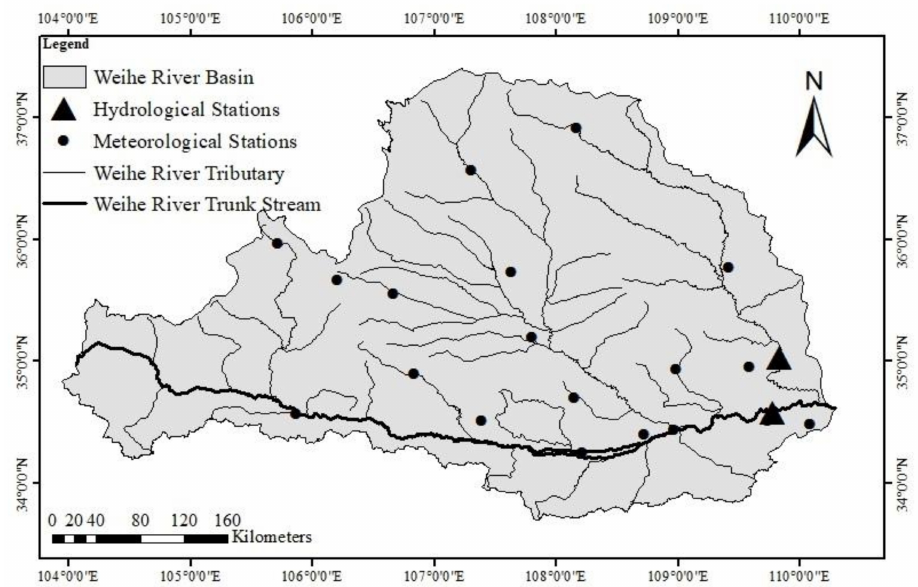
Figure 1. Distribution of meteorological and hydrological stations in the Weihe River